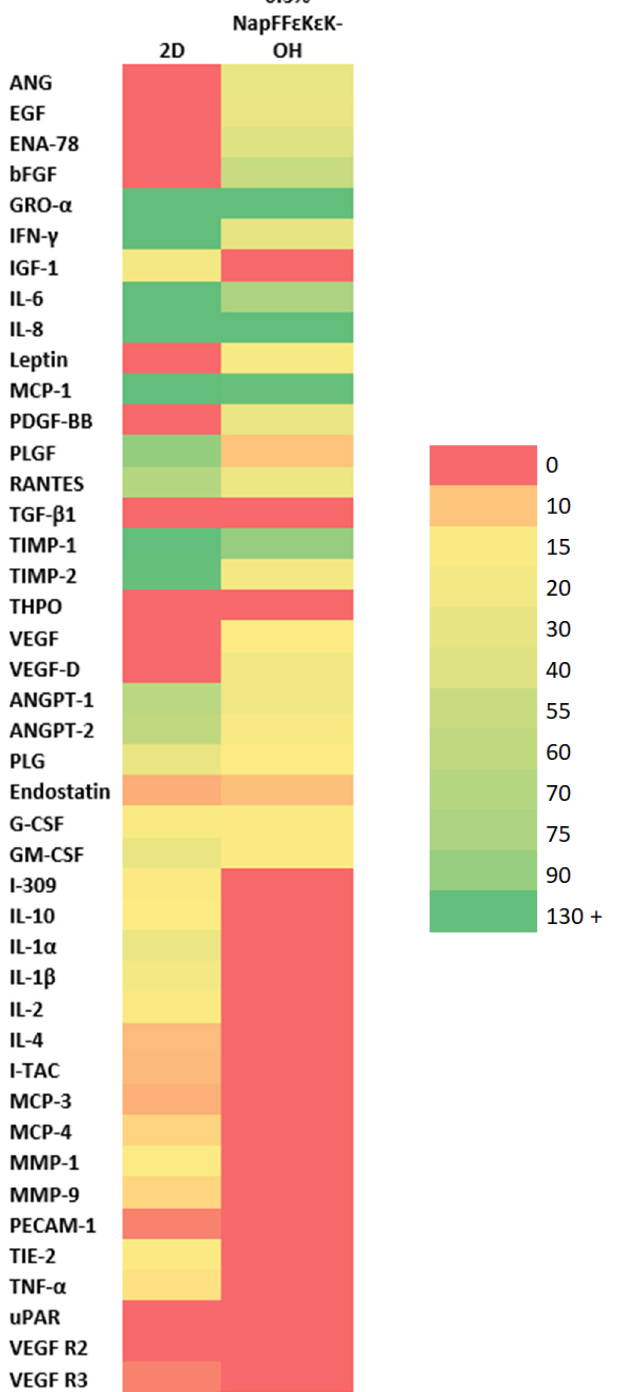
Figure 6. Heat map showing the expression of growth factors/cytokines in conditioned media from DPSCs following 14 days encapsulation in 0.5% w / v NapFF ε K ε K-OH hydrogels versus 2D culture. Heat map comparison showed upregulation of ANG, EGF, ENA-78, bFGF, leptin, PDGR-BB, VEGF and VEGF-D, along with downregulation of IFN- γ , IGF-1, IL-6, PLGF, RANTES, TIMP-1, TIMP-2, ANGPT1, ANGPT2, I-309, IL-10, IL-1 α , IL-1 β , IL-2, IL-4, I-TAC, MCP-3, MCP-4, MMP-1, MMP-9, TIE-2 and TNF α in 0.5% w / v NapFF ε K ε K-OH 3D hydrogel, compared with 2D culture. The heat map was generated in Excel using a 3-colour scale whereby red colour represents no expression above baseline, yellow represents the median expression level of the dataset and green represents the 90% percentile of the expression levels obtained. Colour shading and associated arbitrary values